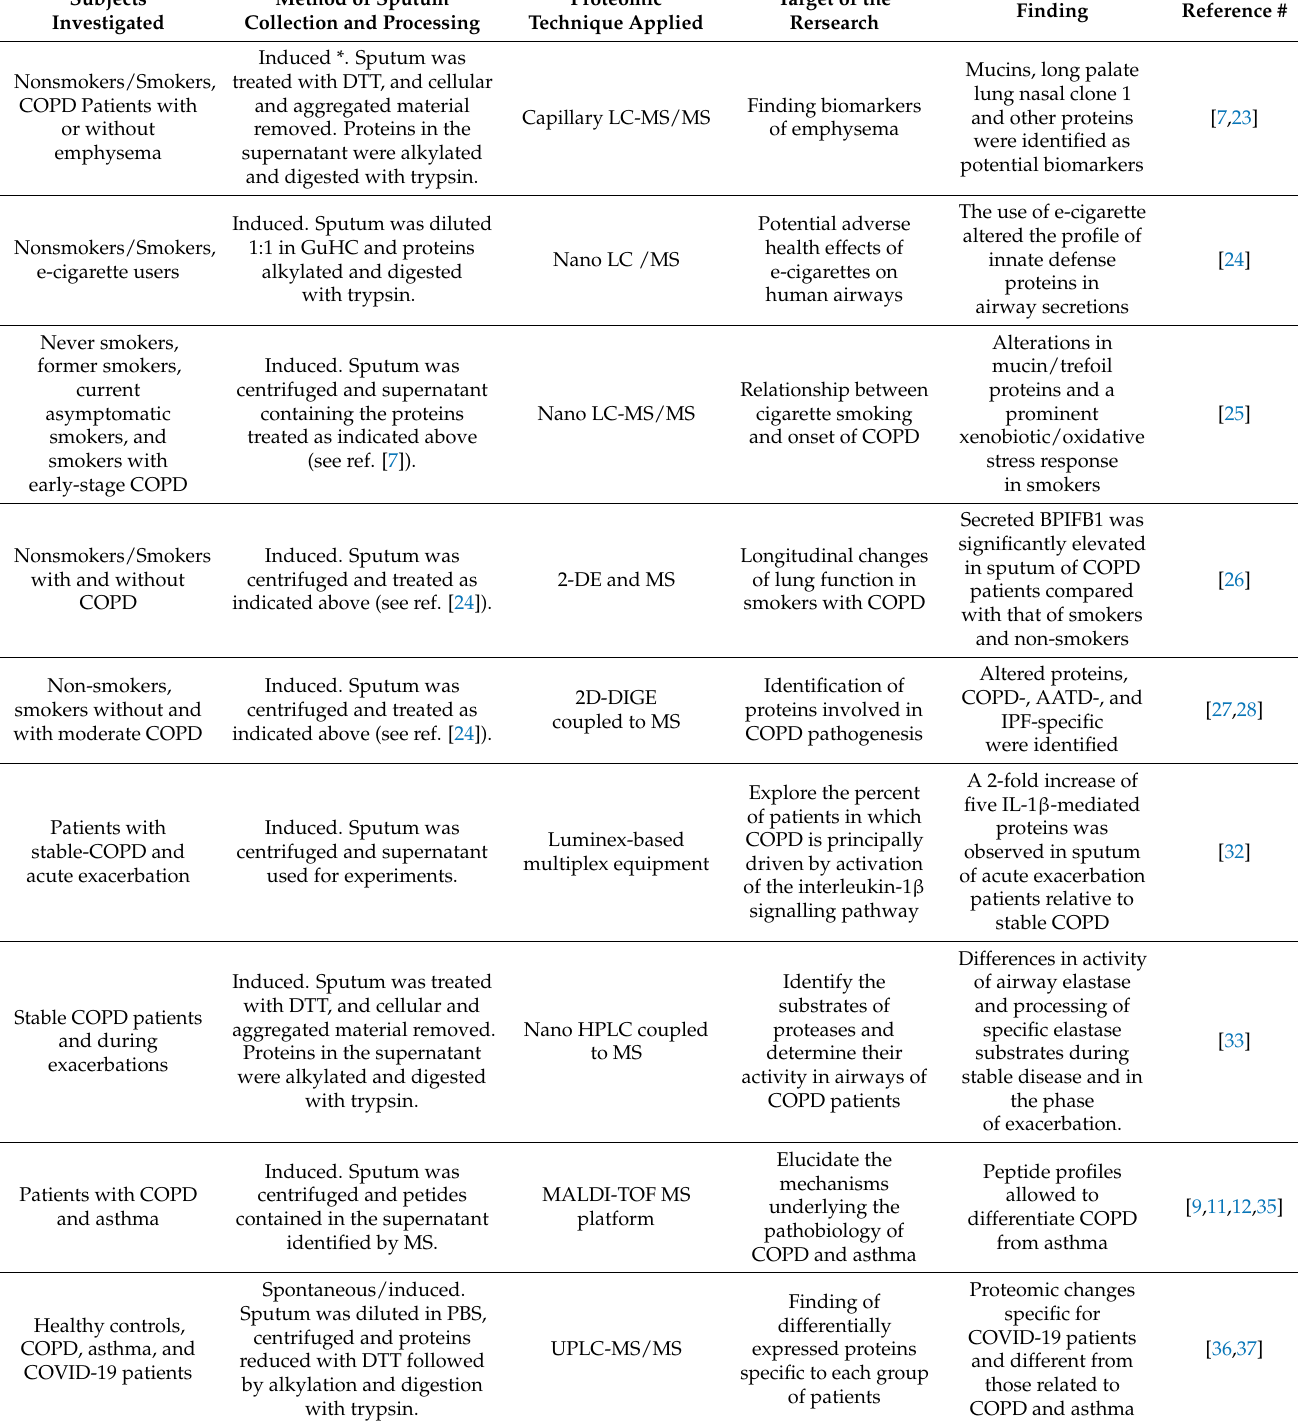
Table 2. List of articles dealing with proteomics of sputum in COPD